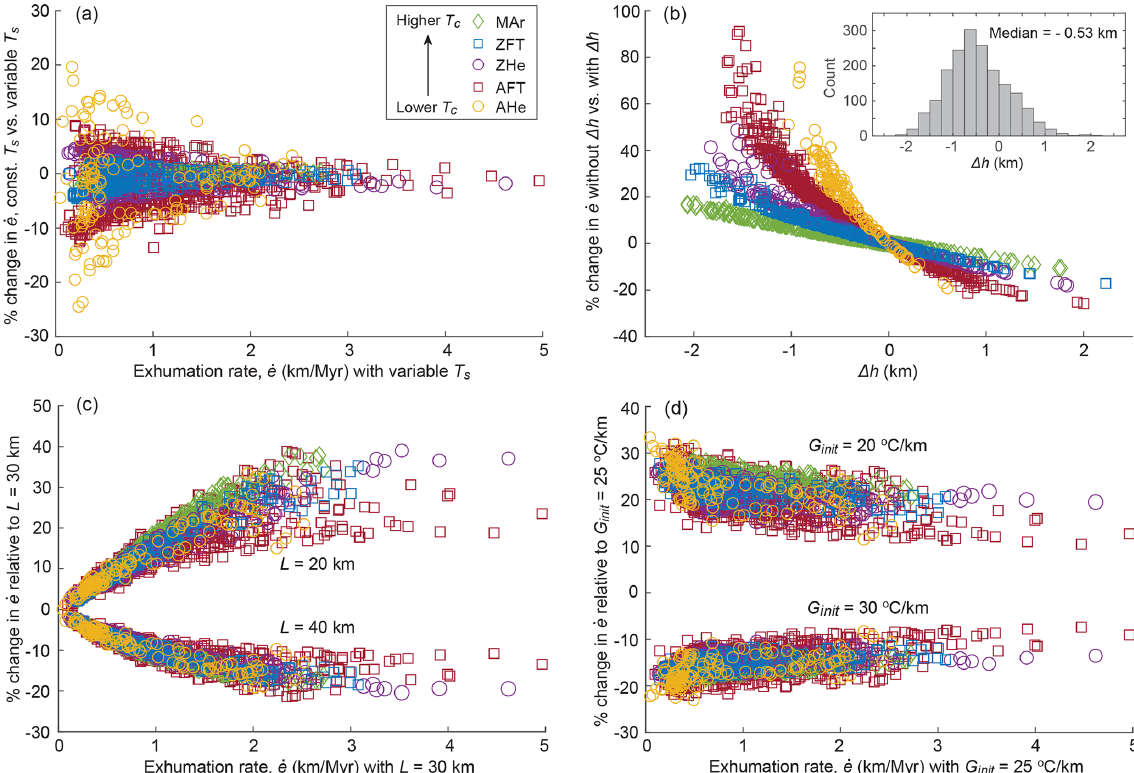
Figure 7. Impact of varying surface conditions and sensitivity to thermal parameters on calculated exhumation rates. (a) Impact of using a variable (elevation-dependent) surface temperature versus a constant surface temperature; (b) impact of including the local relief correction (cid:49)h ; inset shows histogram of (cid:49)h values for the Himalayan dataset. Plots in (a) and (b) show percent change in exhumation rates when the corrections are not included compared to when they are included, i.e., 100 × ( e const. T e with (cid:49)h ) /e with (cid:49)h . (c) Sensitivity of predicted exhumation rates to model thickness L ; (d) sensitivity of predicted exhumation rates to initial, unperturbed geothermal gradient G init . Plots in (c) and (d) show percent change in exhumation rates for varying conditions versus exhumation rate predicted with parameters of Table 1; i.e., 100 × (tested change − default value) / default value, where “default value” is defined as in Table 1. See text for